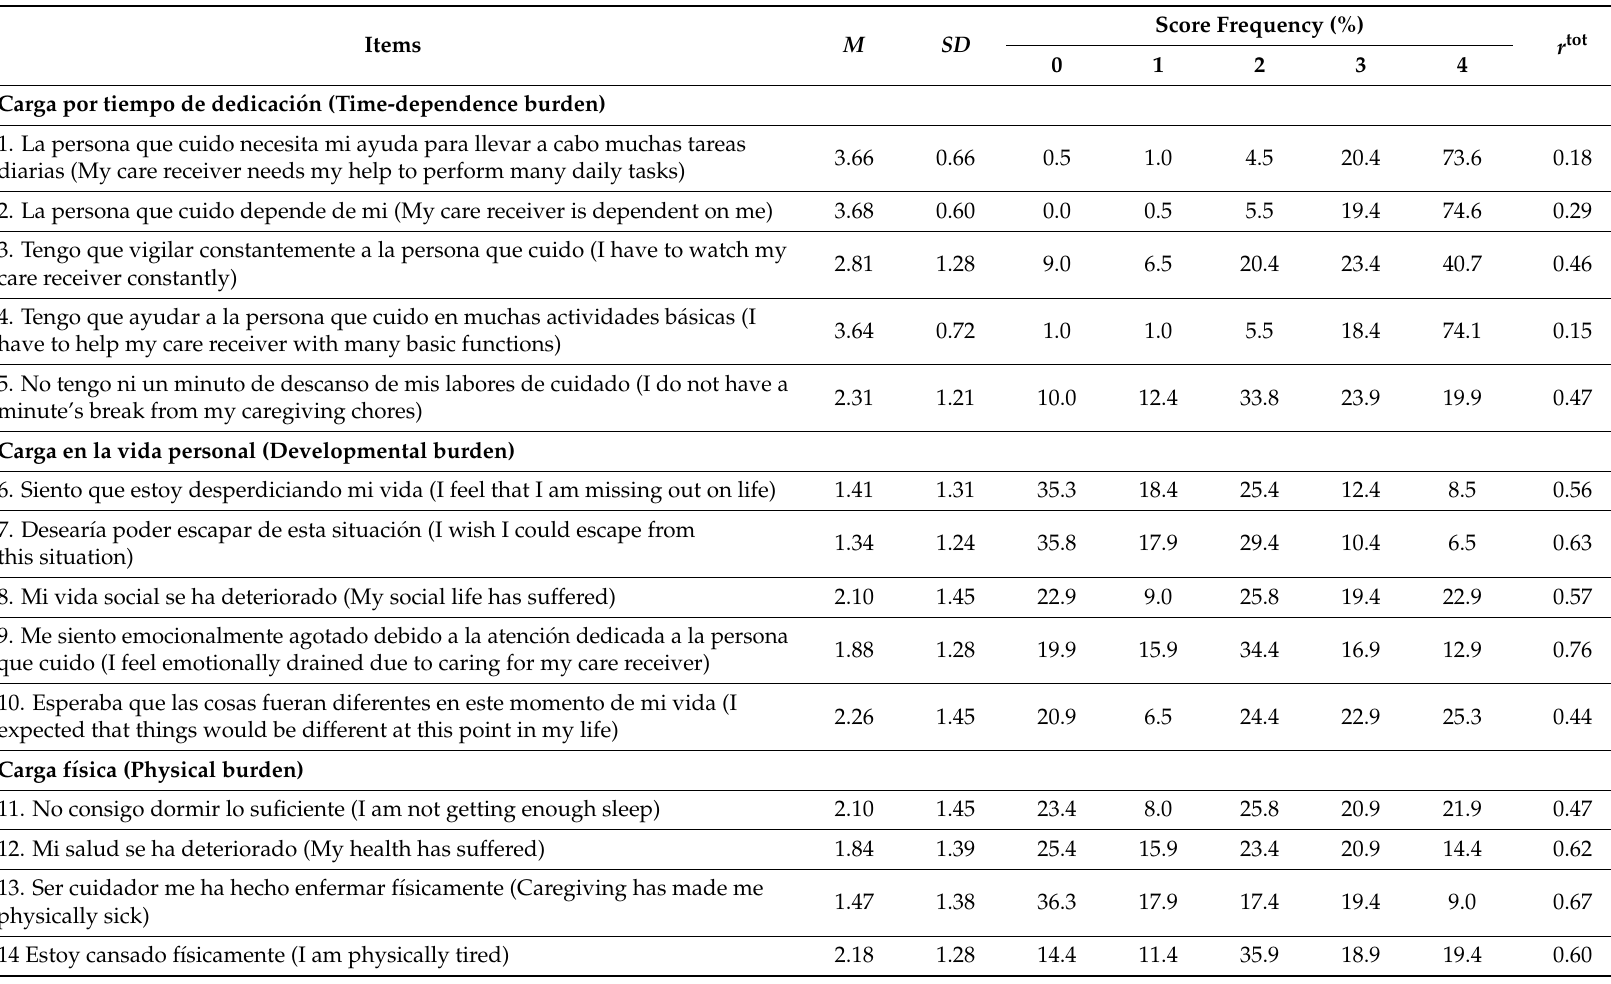
Table 2. Means, standard deviations, score frequency and corrected item-total correlation ( r tot ) for each item of the original Caregiver Burden Inventory (CBI). Items M SD